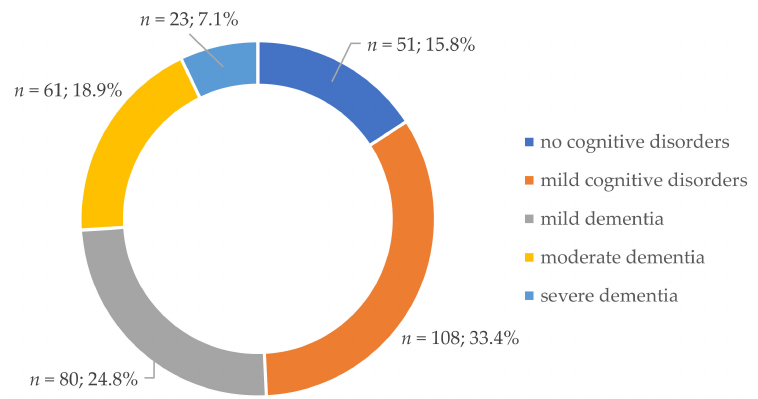
Figure 1. Prevalence of cognitive impairment by severity of disorders.